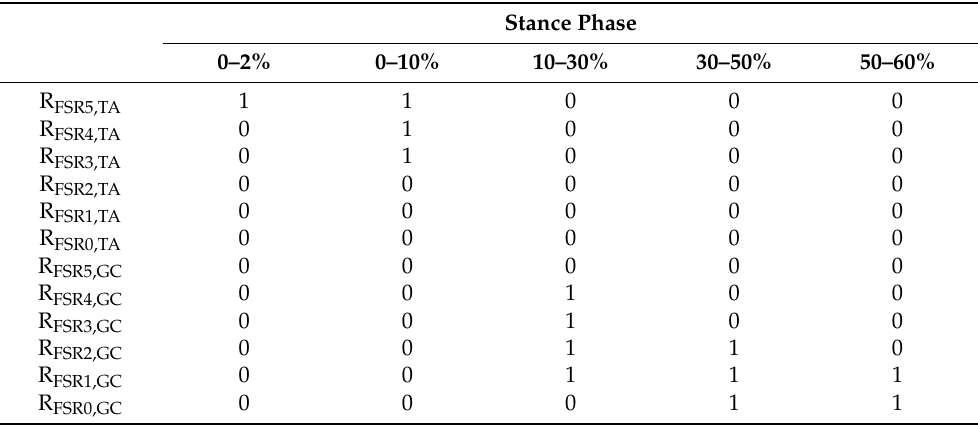
Table 5. Template for the gait map of physiological